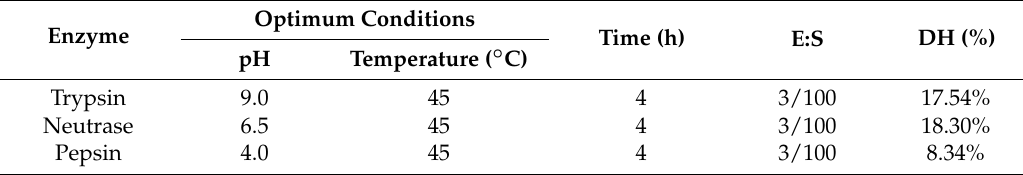
Table 3. Conditions summary of enzymatic